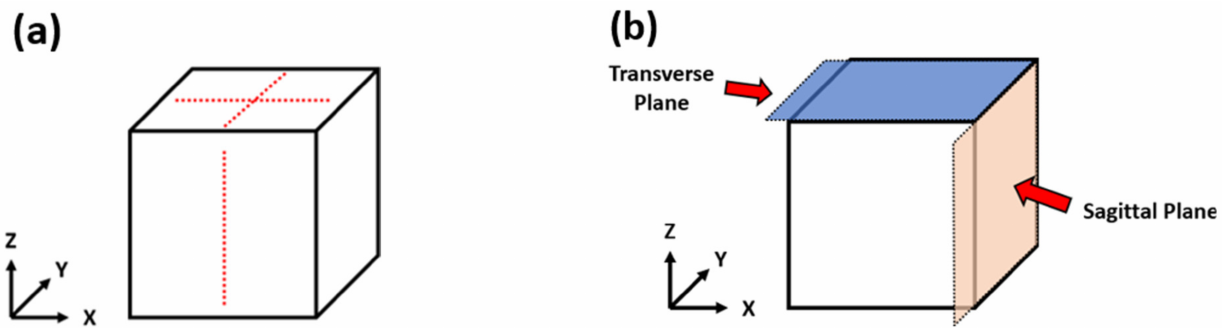
Figure 4. ( a ) The locations of indentations for microhardness analysis and ( b ) the targeted planes